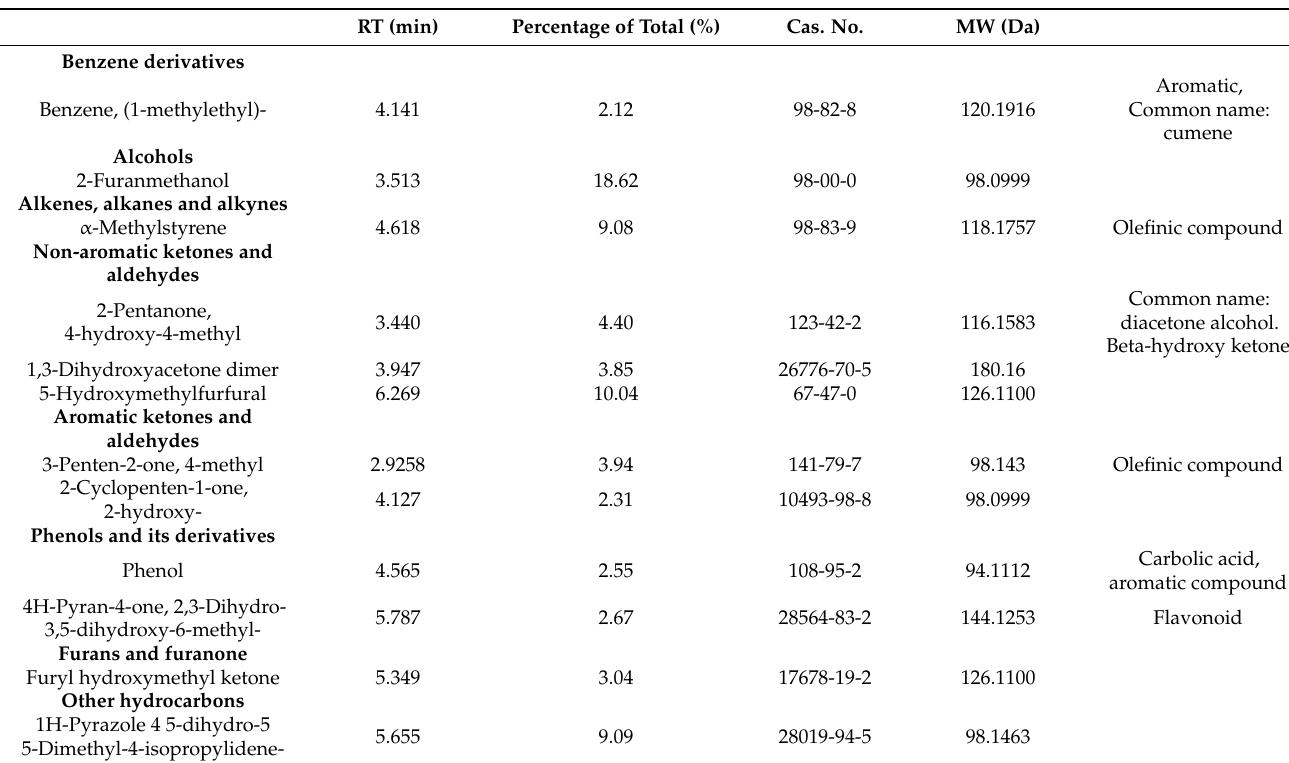
Table 3. Chemical compounds identified in Gelam